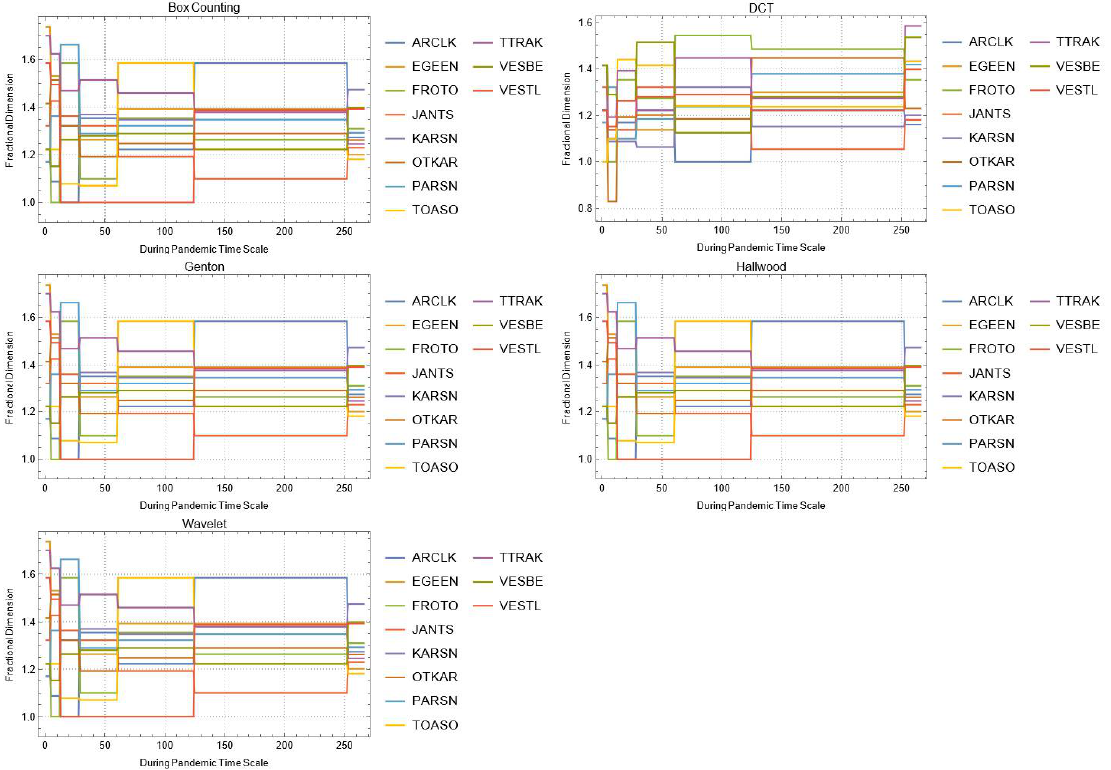
Figure A6. Daily changes of fractal dimensions during the pandemic (chemicals).